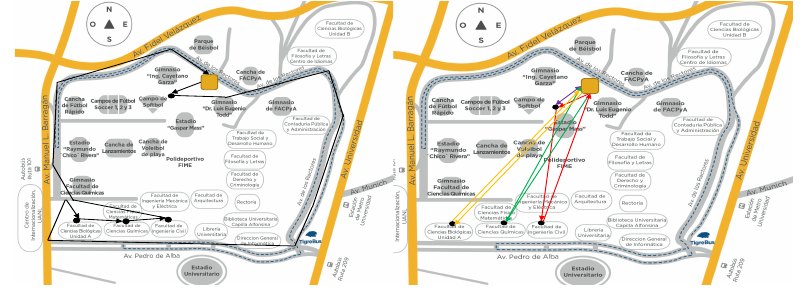
Figure 3. Traditional approach vs modern approach.